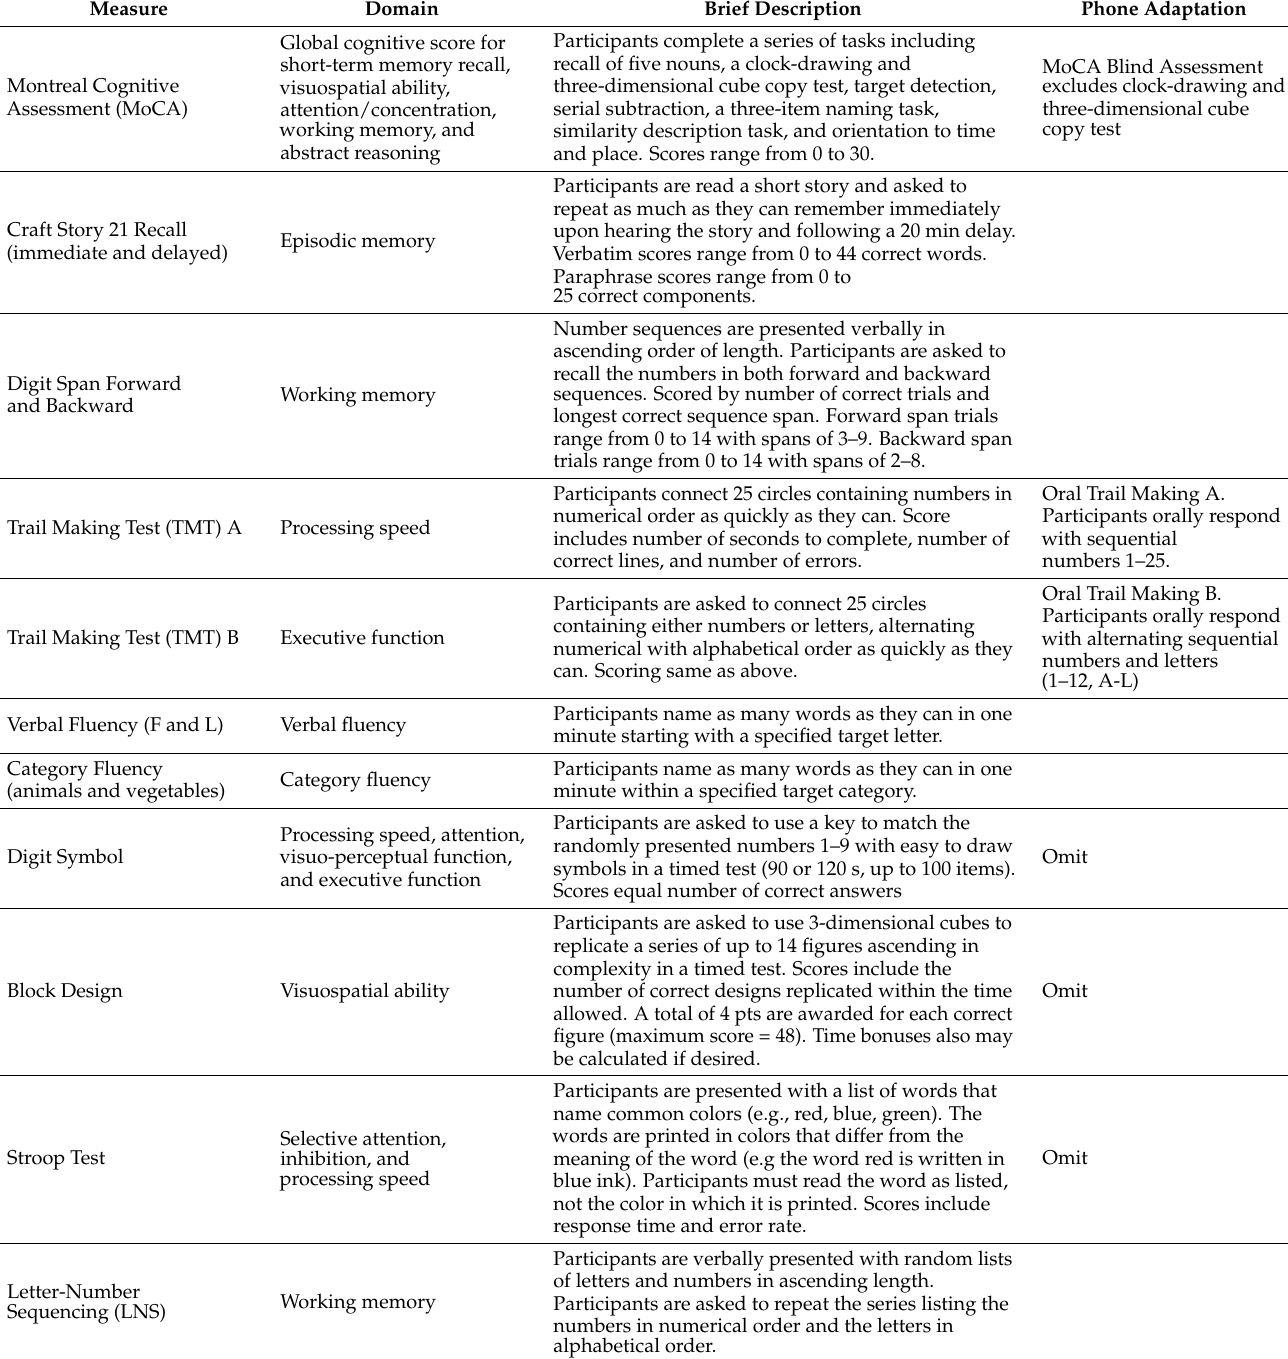
Table 1. Neurocognitive assessment